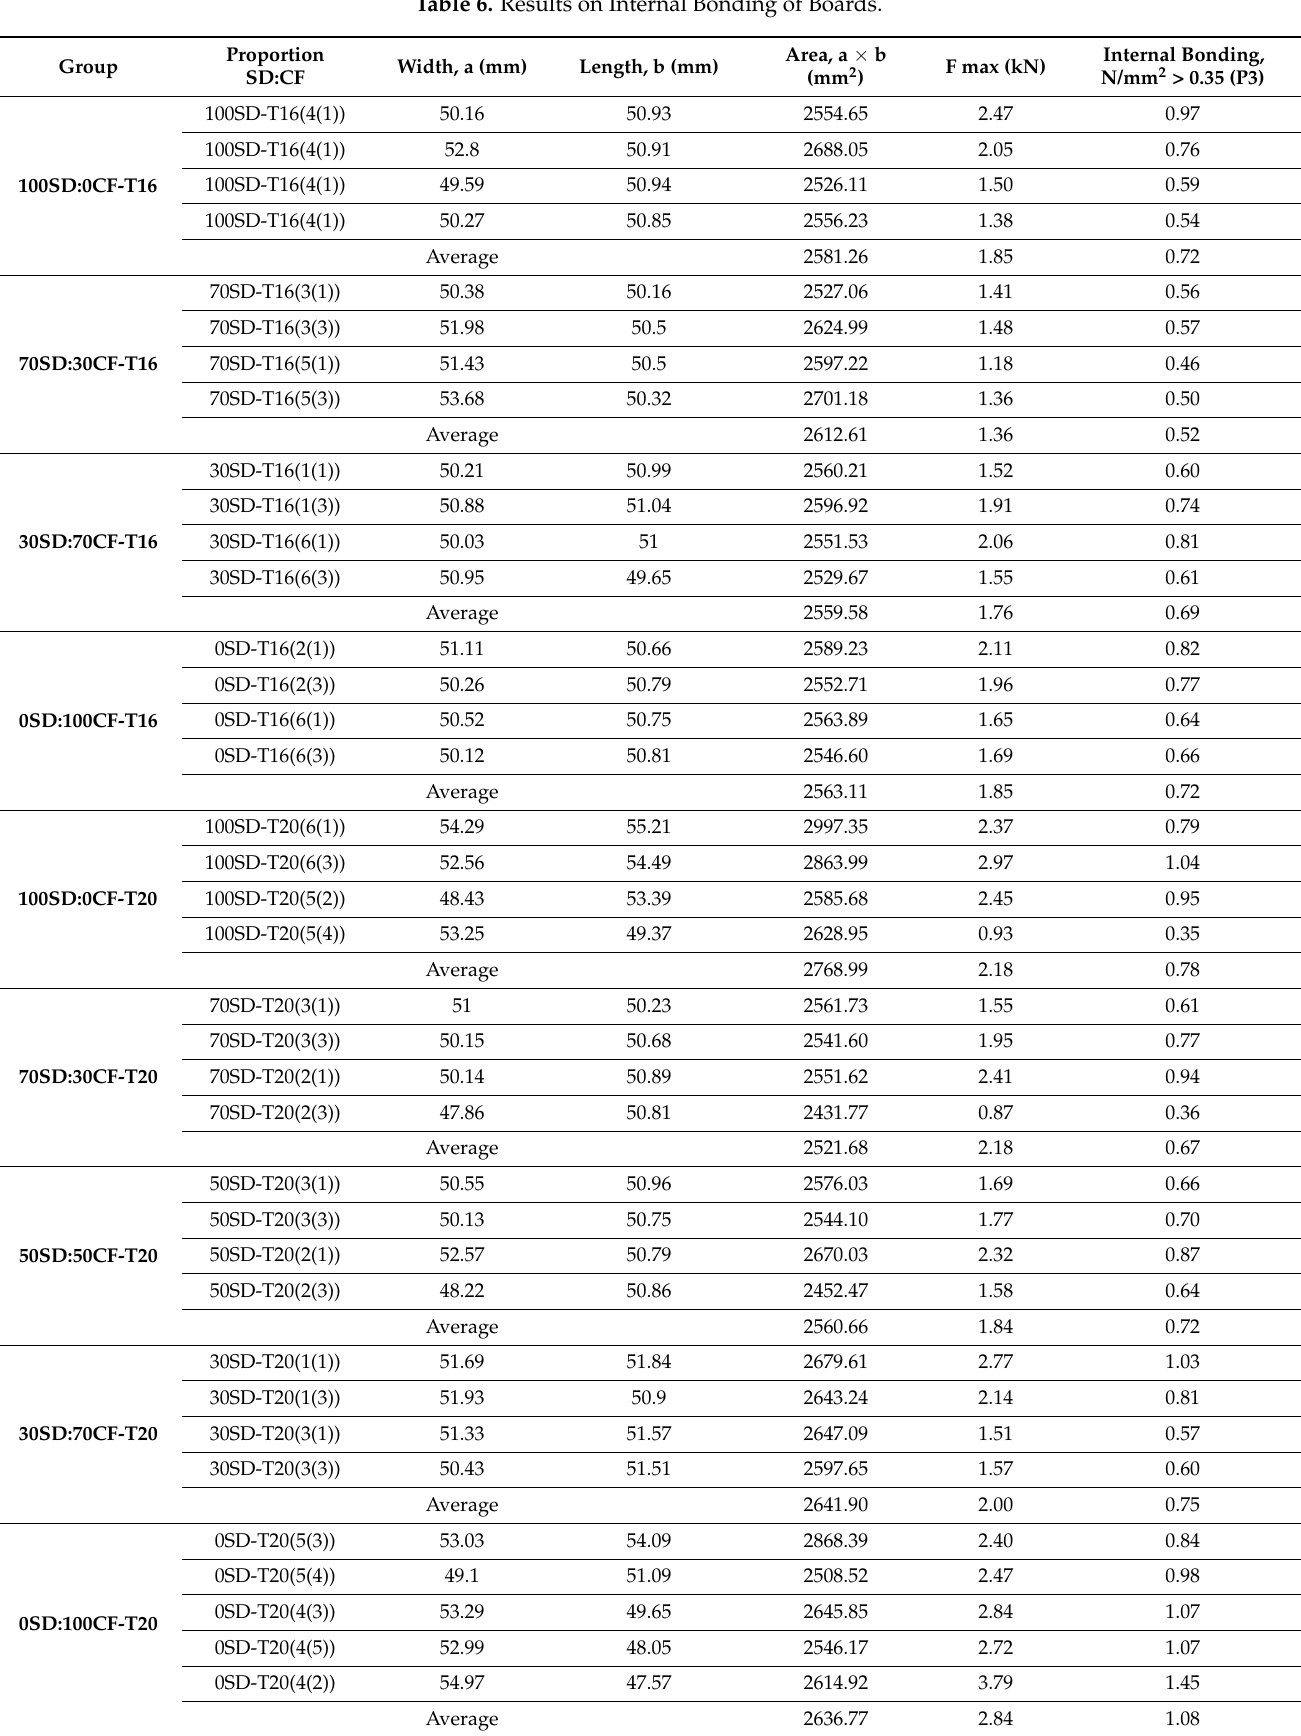
Table 6. Results on Internal Bonding of